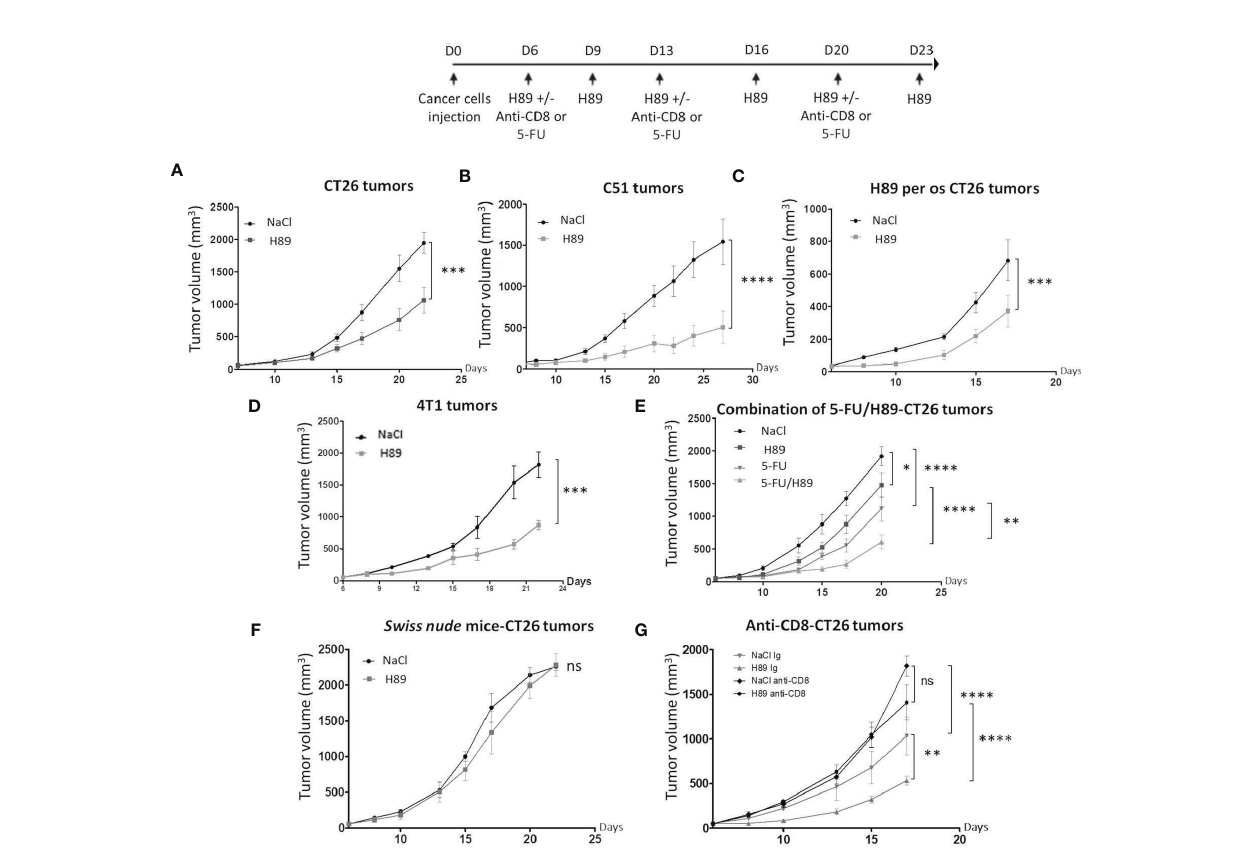
FIGURE 2 | H89 mediates immunotherapeutic activity against colon cancer. (A, B) CT26 or C51 tumor-bearing BALB/c mice (5 × 10 5 murine colon cancer cells in s.c.) were treated, or not (NaCl, i.p.), with H89 (10 mg/kg, i.p.) twice a week, and tumor growth was monitored three times a week ( A , n = 10 mice/group; B , n = 7 mice/group). (C) Oral administration of H89 (5 mg/kg), or NaCl in the control group, twice a week in CT26 tumor-bearing BALB/c mice. Tumor growth was monitored three times a week ( n = 7 mice/group). (D) 4T1 breast cancer cells tumor-bearing mice (5 × 10 5 4T1 cells in s.c.) were treated, or not (NaCl, i.p.), with H89 (5 mg/kg, i.p.) twice a week, and tumor growth was monitored three times a week ( n = 5 mice/group). (E) CT26 tumor-bearing BALB/c mice (5 × 10 5 CT26 cells in s.c.) were treated, or not (NaCl, i.p.), with H89 (10 mg/kg, i.p.) twice a week, in combination with 5- fl uorouracil (5-FU, 5 mg/kg in i.p.) once a week, and tumor growth was monitored three times a week ( n = 14 mice/group). (F) Swiss nude immunode fi cient mice, bearing CT26 tumors (5 × 10 5 CT26 cells in s.c.) were treated, or not (NaCl, i.p.), with H89 (10 mg/kg, i.p.) twice a week, and tumor growth was monitored three times a week ( n = 5 mice/group). (G) CT26 tumor-bearing BALB/c mice (5 × 10 5 CT26 cells in s.c.) were treated, or not (NaCl, i.p.), with H89 (10 mg/kg, i.p.) twice a week. Mice also received anti-CD8a or control IgG injections once a week (500 µg in i.p.), and tumor growth was monitored three times a week ( n = 7 mice/group). Statistically signi fi cant differences were determined by using two-way ANOVA: * p ≤ 0.05; ** p ≤ 0.01; *** p ≤ 0.001; **** p ≤ 0.0001; n.s., nonsigni fi cant